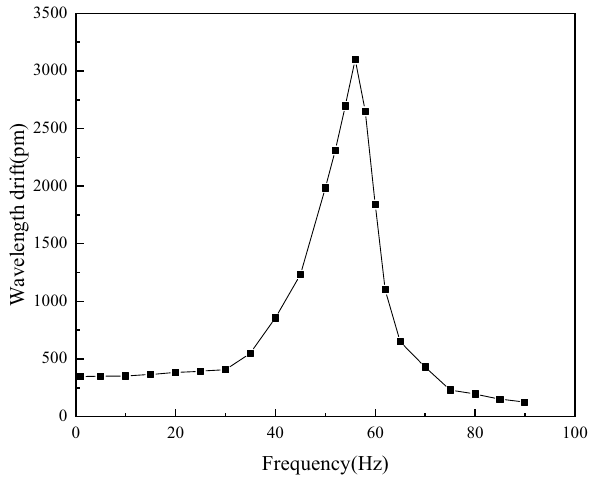
Figure 12. Amplitude-frequency characteristics of the sensor.